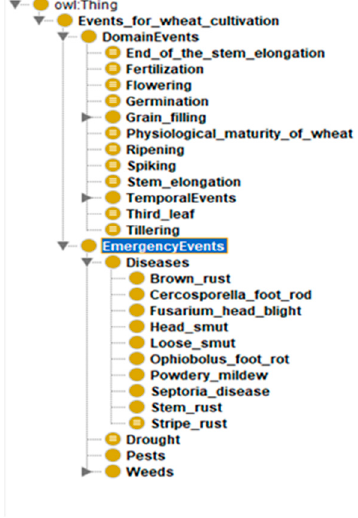
Figure 13. Taxonomy of event concepts.